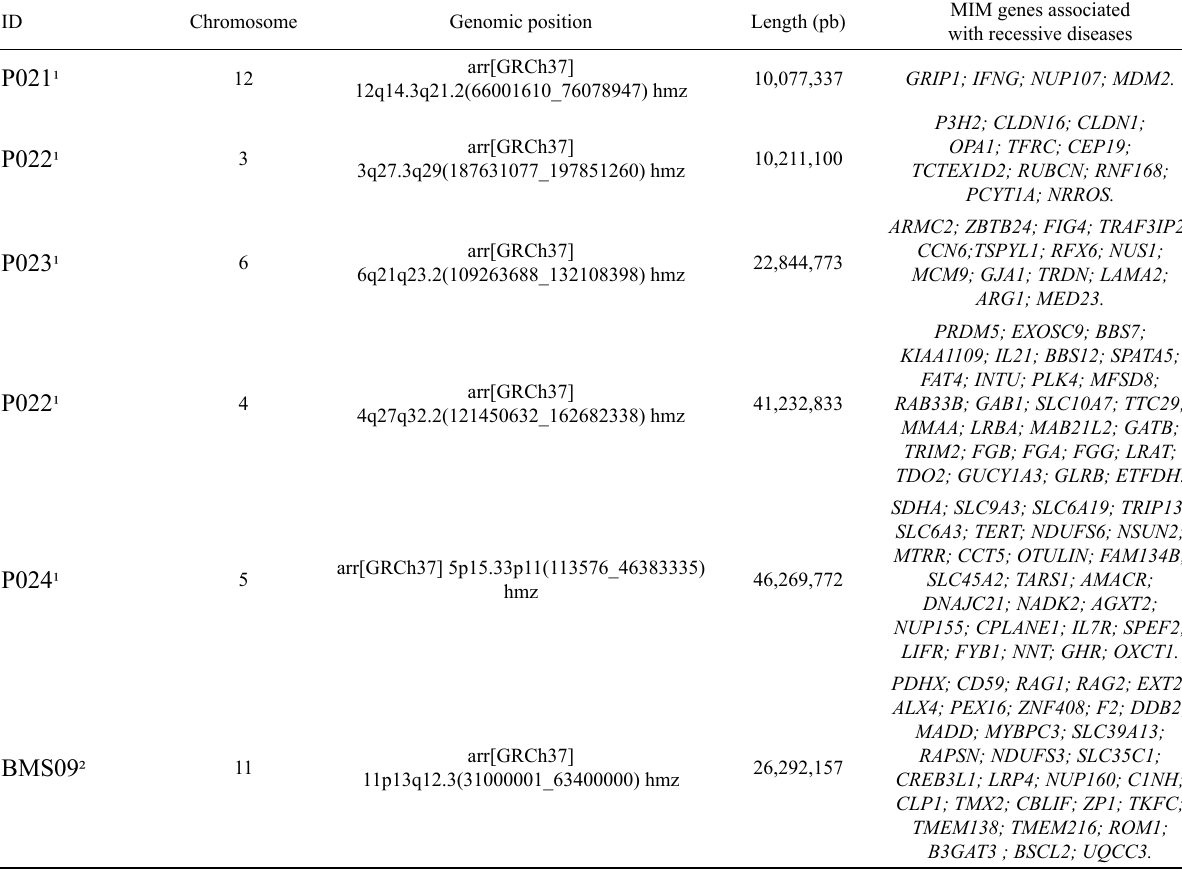
Table 2 – ROH≥10Mb detected on single chromosomes in five patients and one control